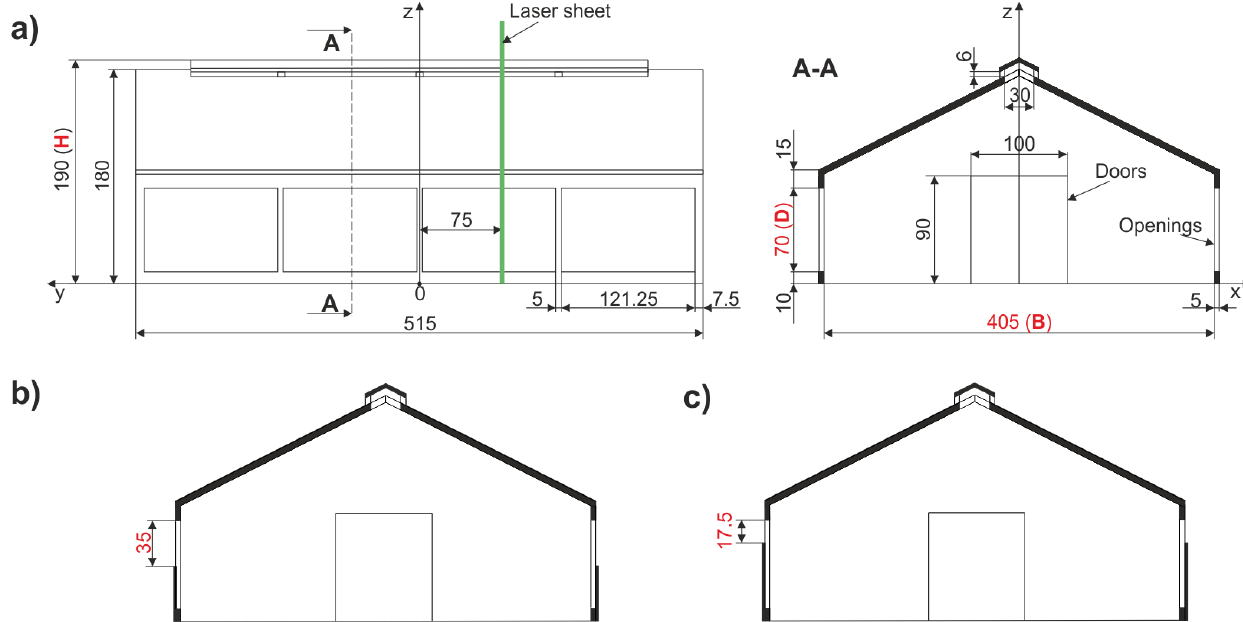
Fig. 1. Sketch of the studied cattle barn model at the scale of 1:50 with respect to the wind-tunnel coordinates: a) side view (left) and the cross-section of the cattle barn in the case of the fully open configuration. Cross-sections of the b) half and c) quarterly open configuration. The doors were left open during the all studied cases. All dimensions are in mm.